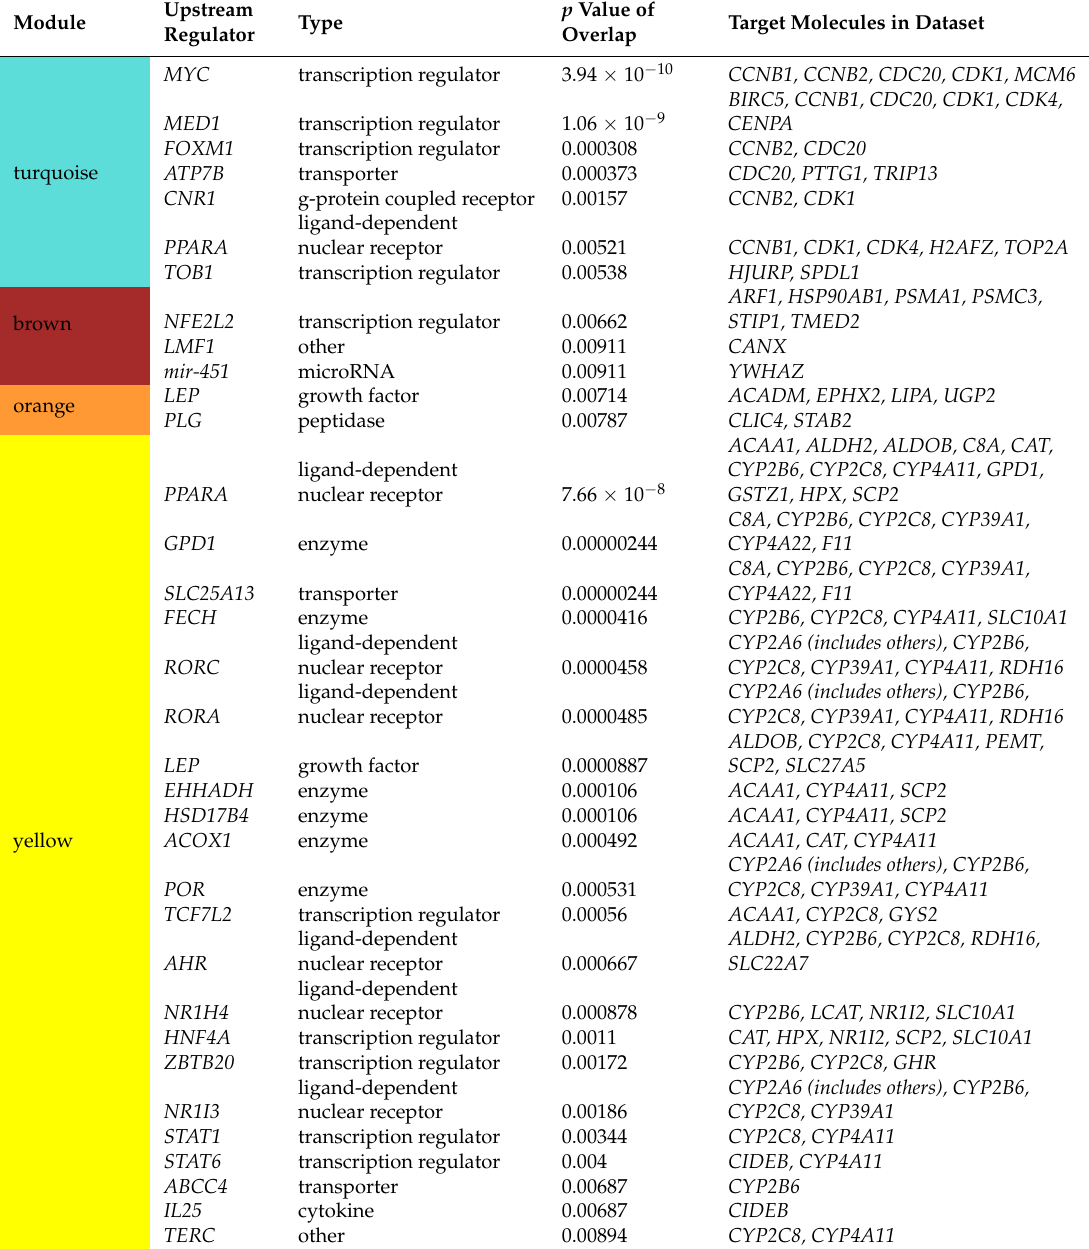
Table 1. Upstream regulators of selected modules predicted by